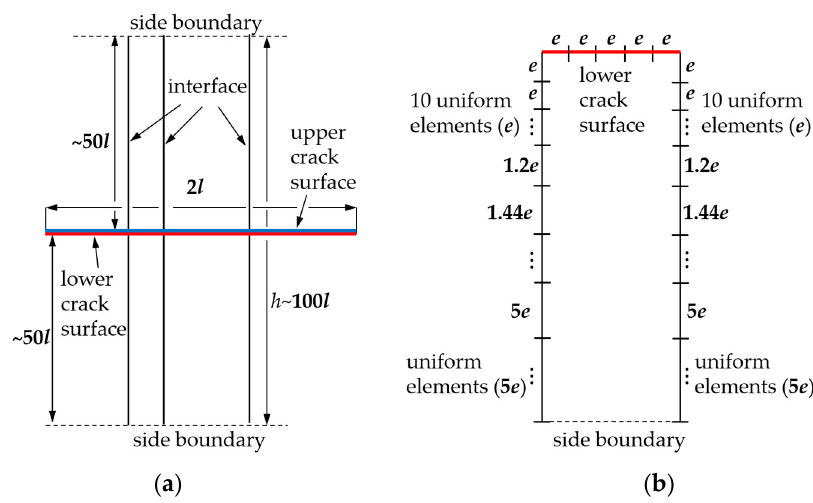
Figure 5. Schematic view of ( a ) crack surface, interfaces, and side boundaries; ( b ) discretization of the lower part of an inner layer.